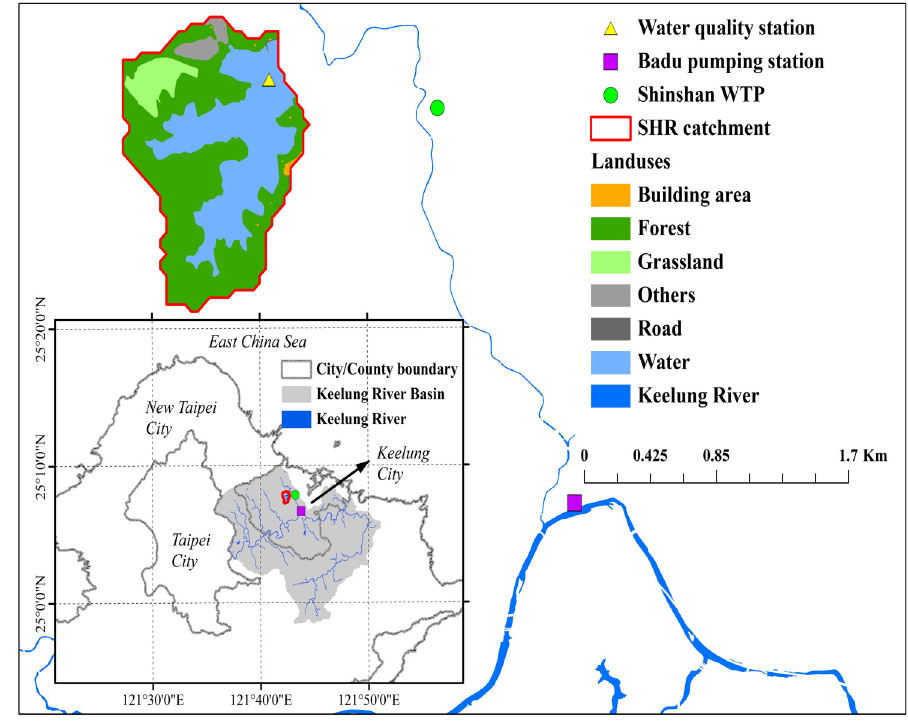
Figure 1. The geographic location of Hsinshan